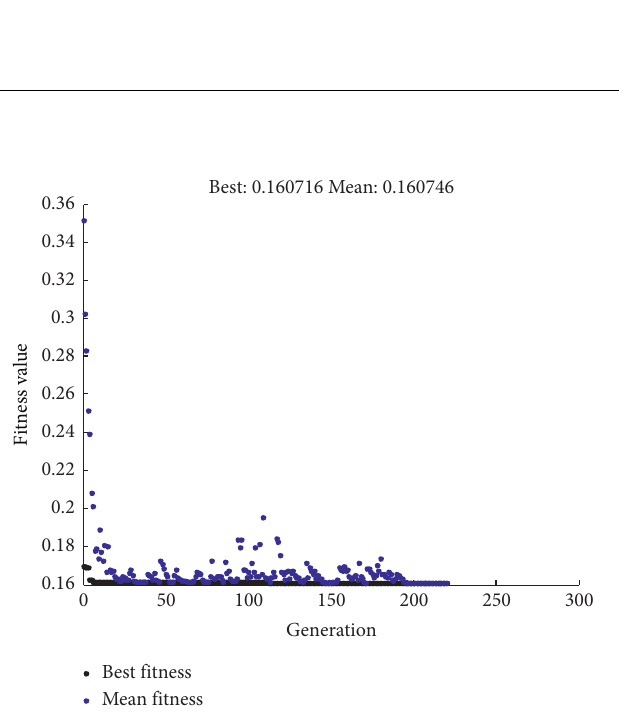
Figure 6: Evolutionary process of fitness